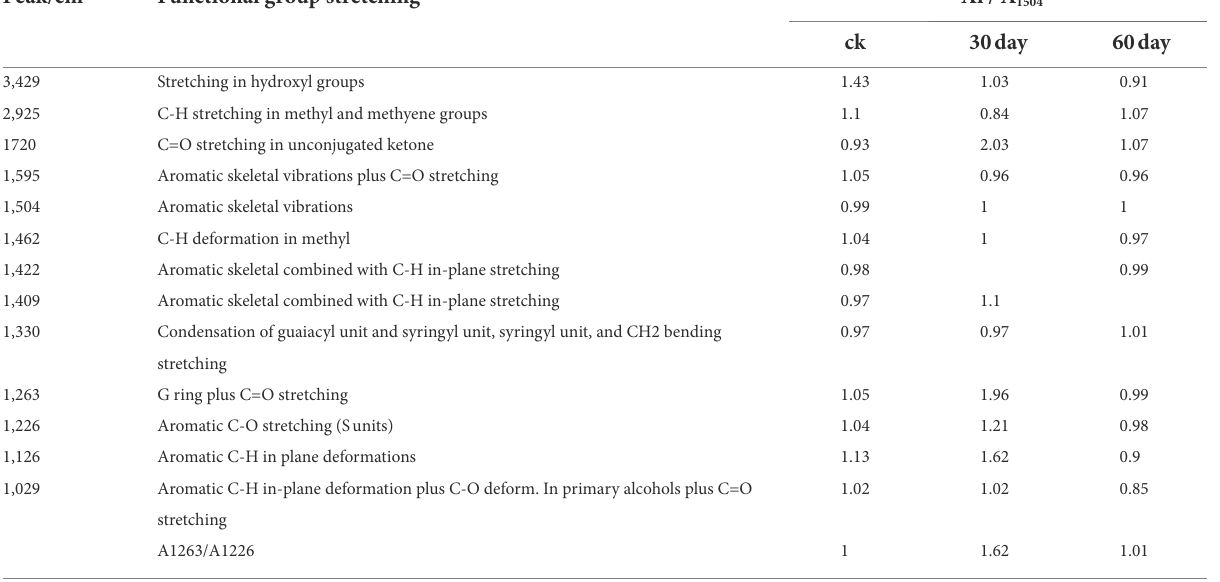
TABLE 2 Infrared spectrum analysis of cotton stalk lignin after degradation. Peak/cm −